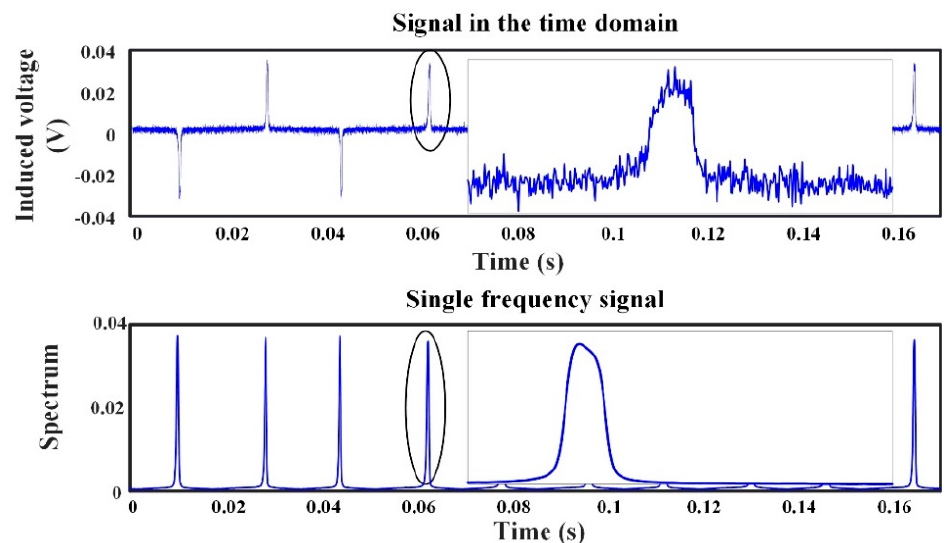
Figure 5. Induced signal in the time domain (upper, @30 Hz) versus single-frequency signal (nether, f = f 0 = 30 Hz); zoom in on the horizontal axis only.